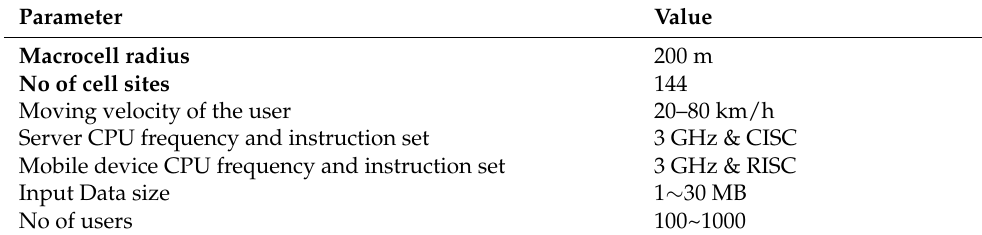
Table 2. Simulation settings and values.